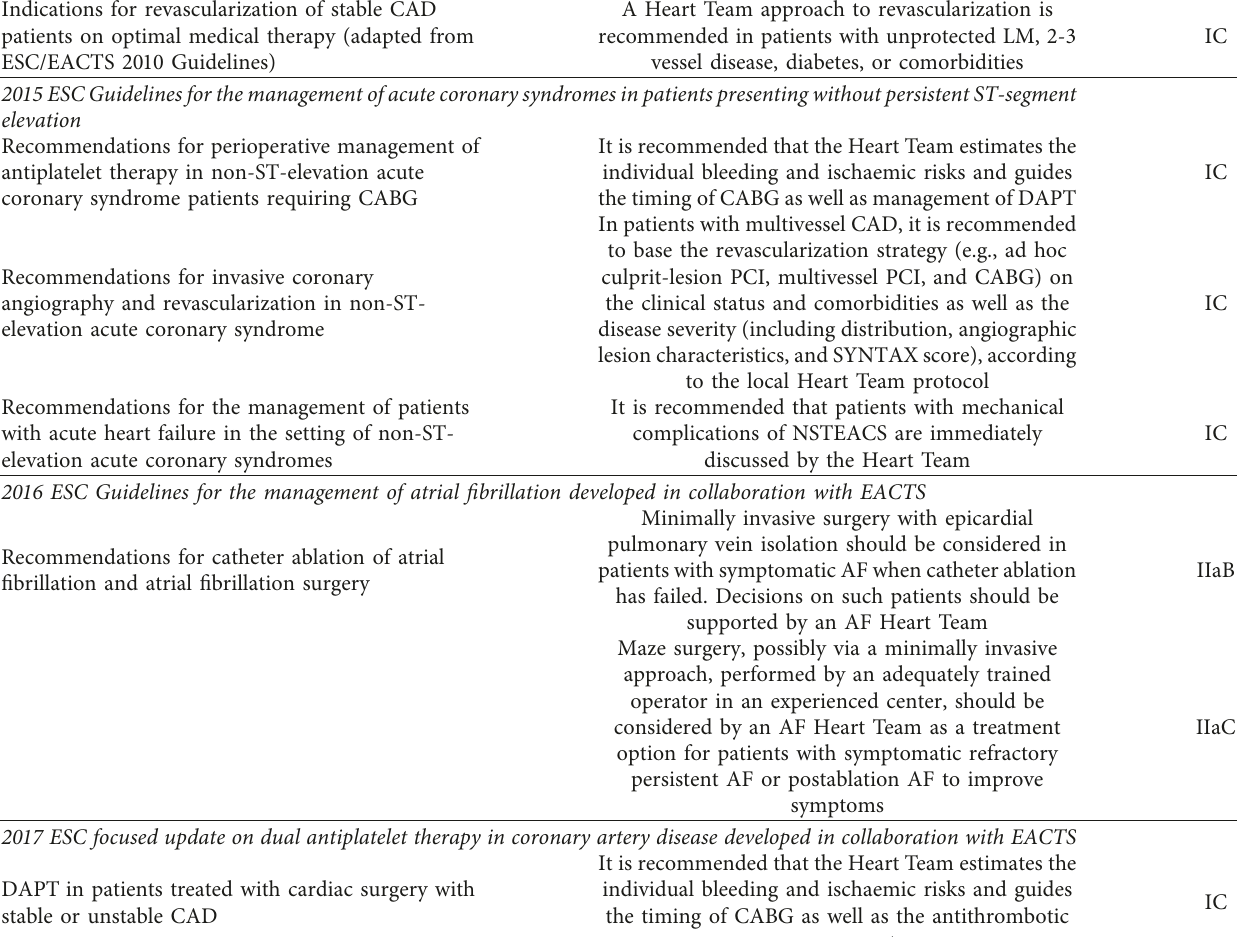
Table 1: Heart Team approach recommendations through the ESC Guidelines referring to coronary artery diseases. 2013 ESC Guidelines on the management of stable coronary artery